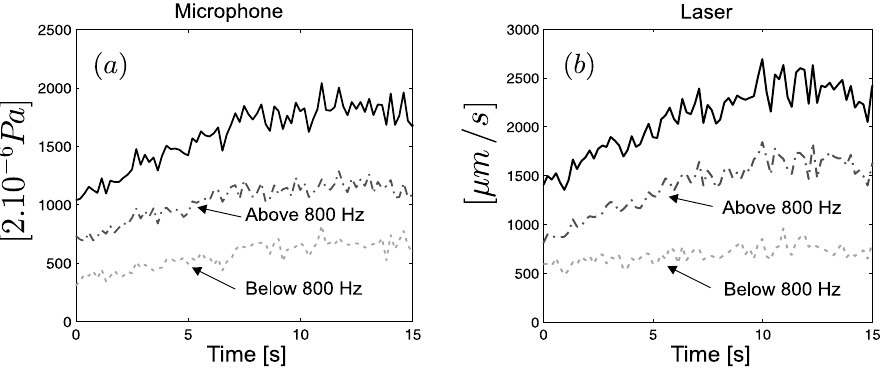
Fig. 10. Time evolution of the RMS value of (a) The sound emitted from the wheel-rail contact; (b) The lateral velocity of the wheel